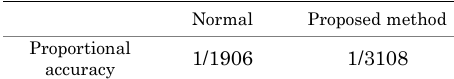
Table 3. Result of proposed method